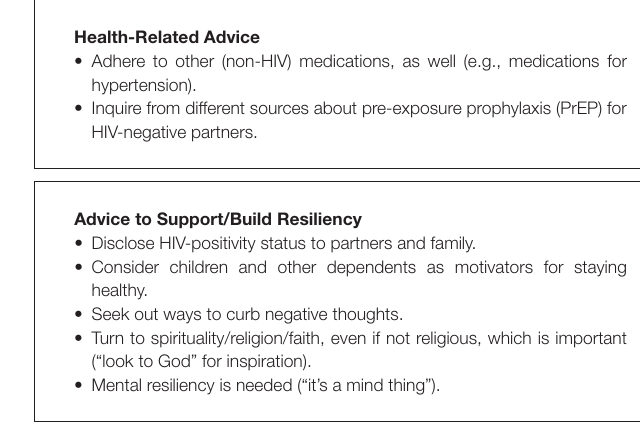
TABLE 1 | Focus group qualitative results. Barriers to adherence ( N = 8 Women; N = 24